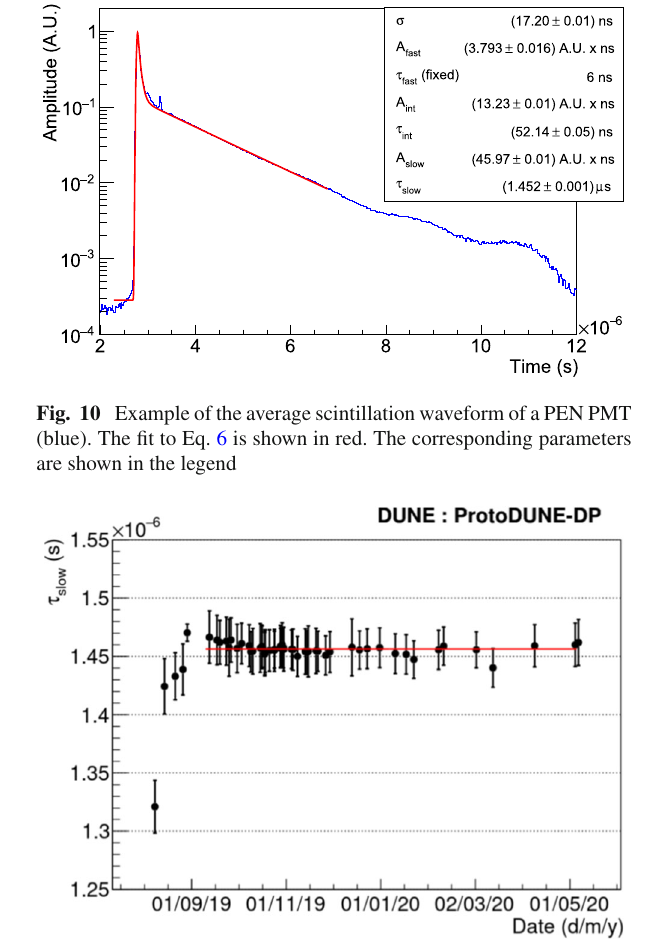
Fig. 11 Monitoring of the τ slow component of the scintillation time profile during the detector operation. The error bars show the STD of the measurements for the different PMT waveforms. Red line at τ = 1 . 46 µ s shows the average from September 2019 when stable slow operation